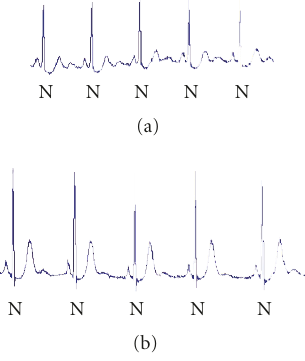
Figure 7: Raw tracing of ECG for patient 106 in the MIT-BIH database with normal beats: (a) ECG corresponding to time 16 : 54 in the file. (b) ECG corresponding to time 21 : 26 in the file. Morphology-based analysis places the beats shown in (a) and (b) into separate clusters based on changes in amplitude.